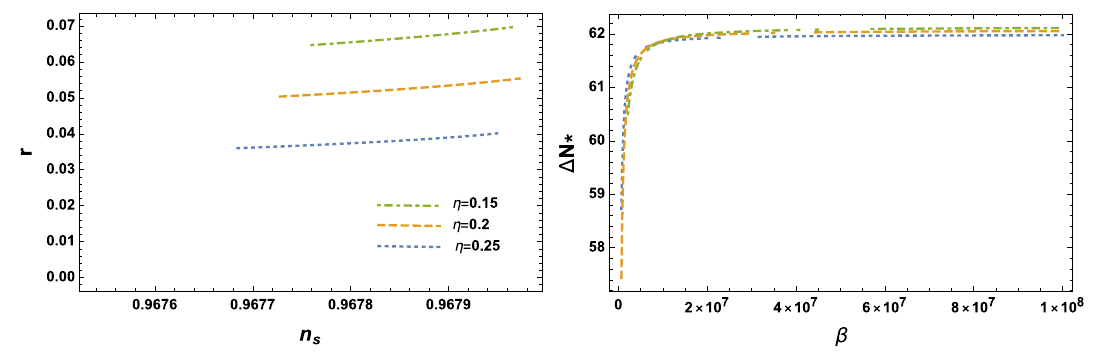
Fig. 19 n s vs r for the natural potential (4.27) in the β -interval 10 5 ≤ η ≤ 10 8 and assuming f = 10 − 3 M p . The curves correspond to η = 0 . 15 , 0 . 2 , 0 . 25. All curves are in the region favored by observa-